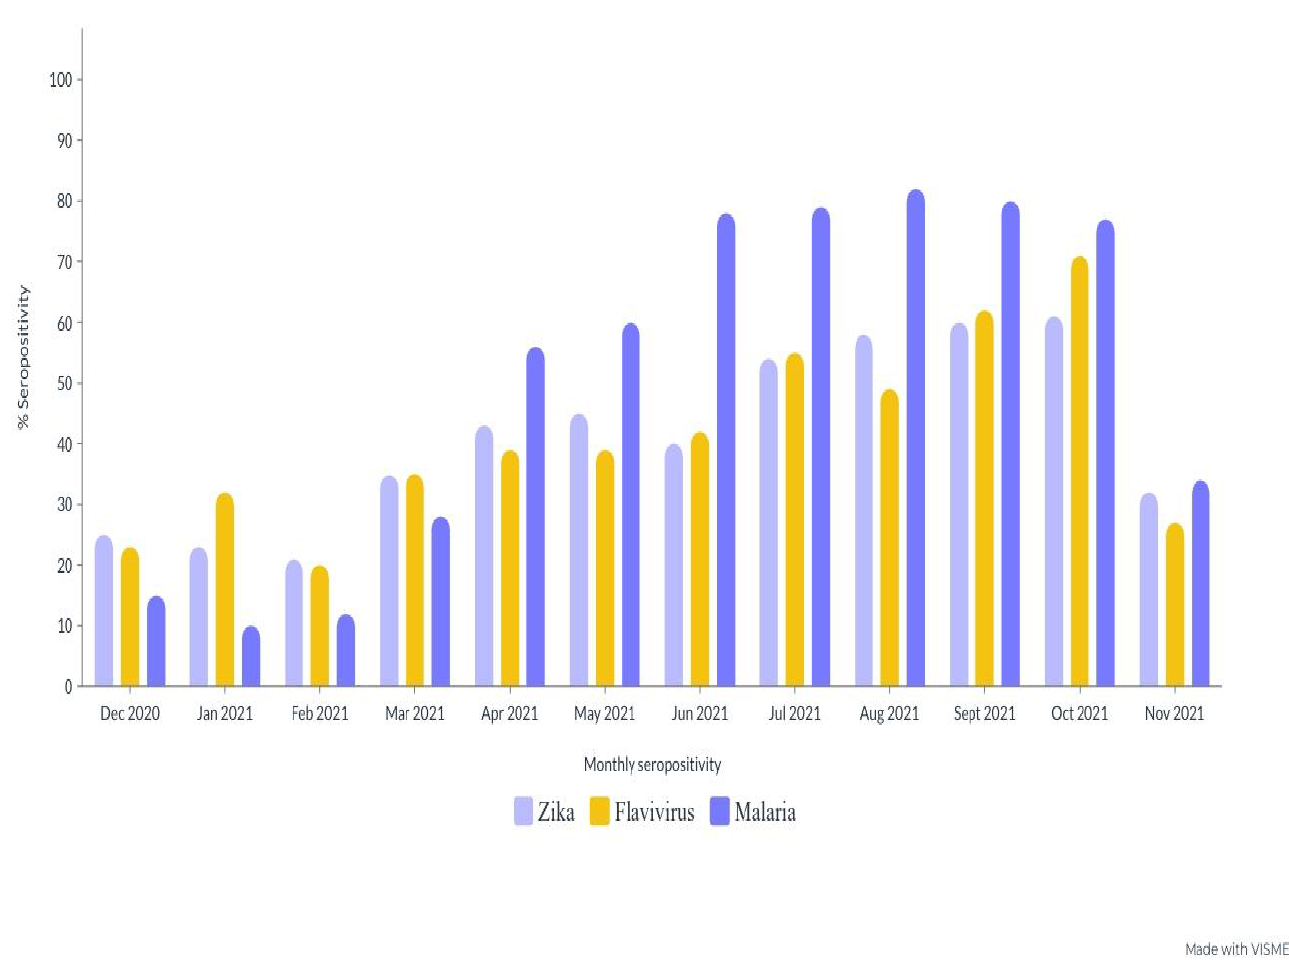
Figure 4. Monthly antibody seropositivity for ZIKV, FLAVI, and malaria during the sampling pe- riod.